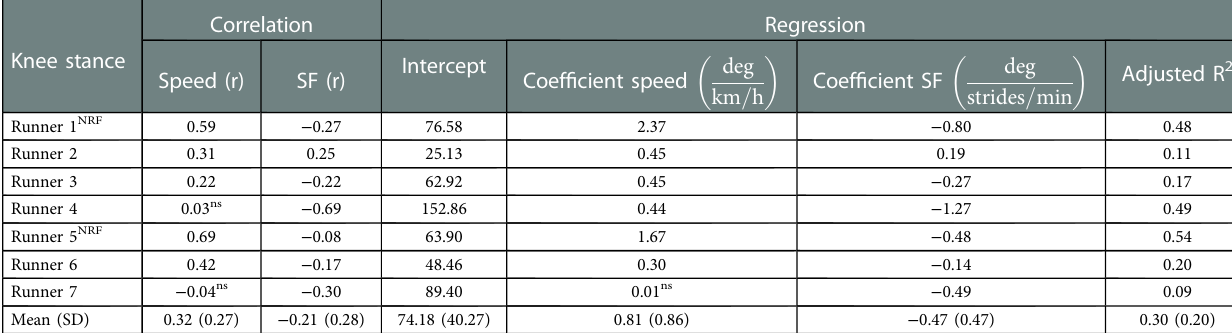
TABLE 3 Left side of table: individual correlations of maximum stance phase knee angles with speed and stride frequency (SF). Right side of table: Individual regression equations to predict maximum stance phase knee angles based on speed and stride frequency together with the adjusted Rsquared value (i.e., explained variance of regression equation). r, Pearson ’ s correlation coef fi cient; SD, standard deviation; ns, non-signi fi cant fi nding; NRF, non-rearfoot striking